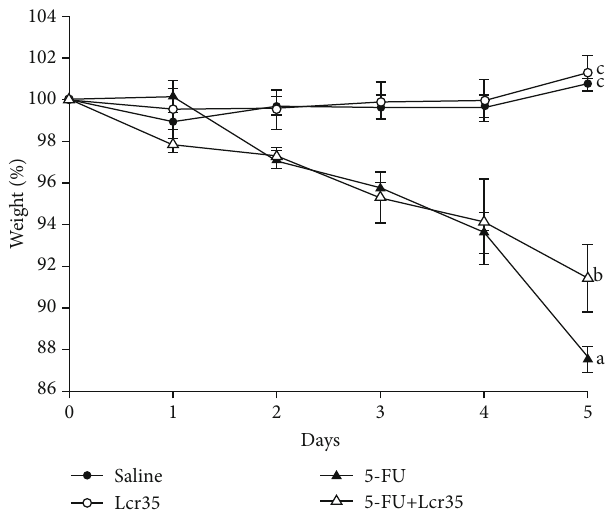
Figure 1: Daily body weight change in saline- or 5-FU-injected mice with/without probiotic Lcr35 administration. The mice were weighed daily, and the results of all groups were compared with those of 5-FU-saline groups for 5 days. In the control groups, the mice were injected with saline and administrated with saline or Lcr35. In the experimental groups, the mice were injected with 5- FU and administrated with or without Lcr35. Data on starting body weight are expressed as 100% from day 0. The body weight percentage sharply decreased from the 2 nd day after 5-FU treatment. The weight percentage of the 5-FU+Lcr35 group ( 91 : 41 ± 1 : 57 % ) was signi fi cantly decreased when compared to that of the 5-FU group ( 87 : 53 ± 0 : 63 % ) ( p = 0 : 009 ). Statistical analysis was performed by one-way